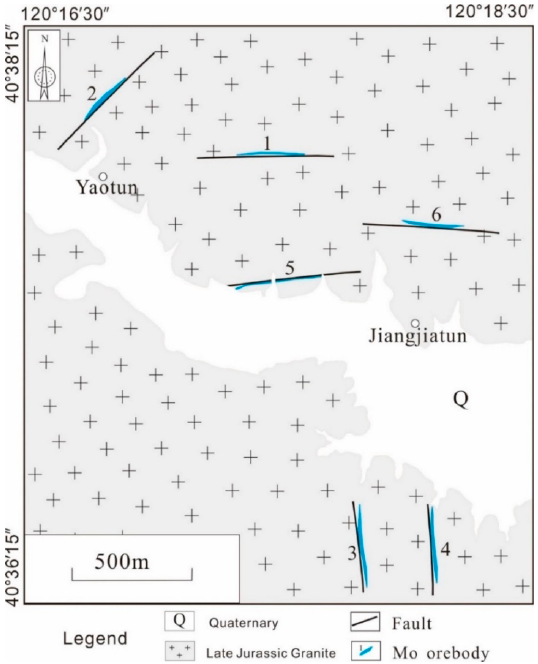
Figure 2. Geological map of the Jiangjiatun molybdenum deposit (242 Brigade Liaoning Province Nuclear Industry Geology Bureau, 2006 [28]). Number 1–6 represents the number of Mo ore bodies at Jiangjiatun.